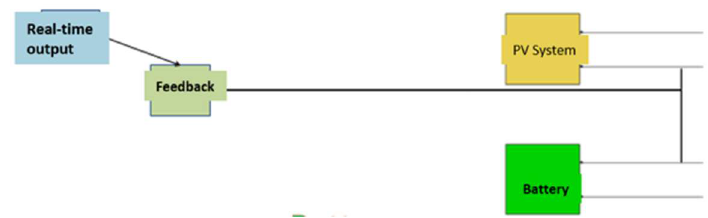
Figure 12. Simulink model of microgrid.